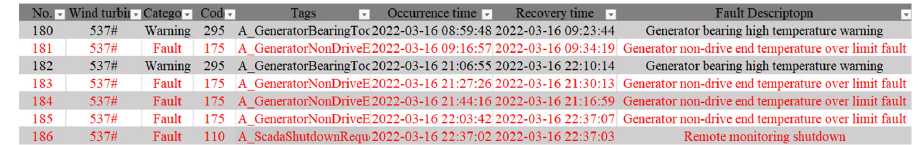
Figure 10. Wind turbine operation logs.